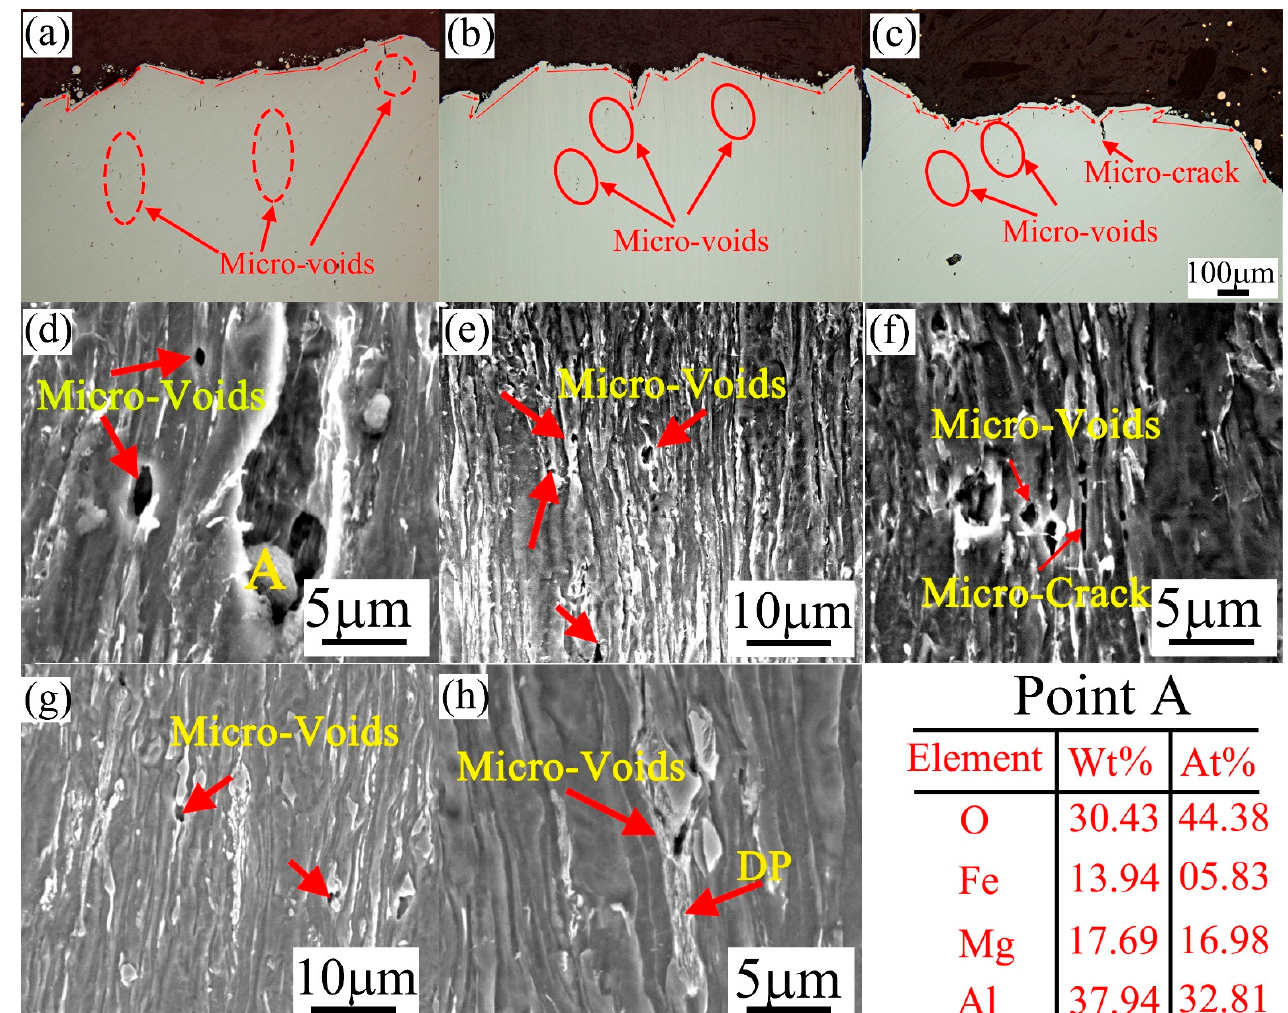
Figure 10. OM morphologies of the surfaces perpendicular to the tensile facture: ( a ) single-phase, ( b ) dual-phase, ( c ) triple- phase; SEM microstructures: ( d – f ) dual-phase, ( g – h ) triple-phase.